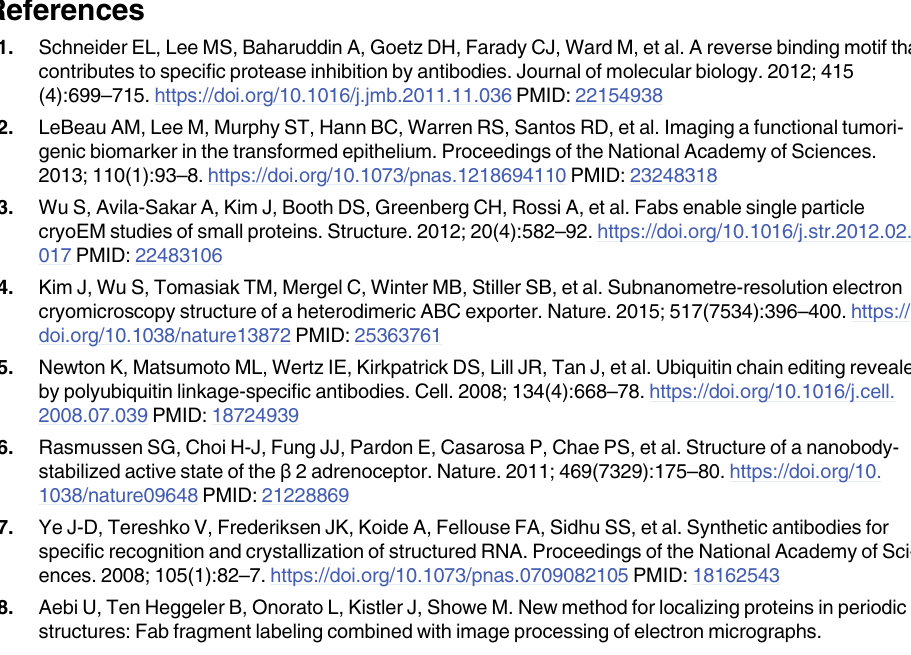
S1 Table. Summary of Fab